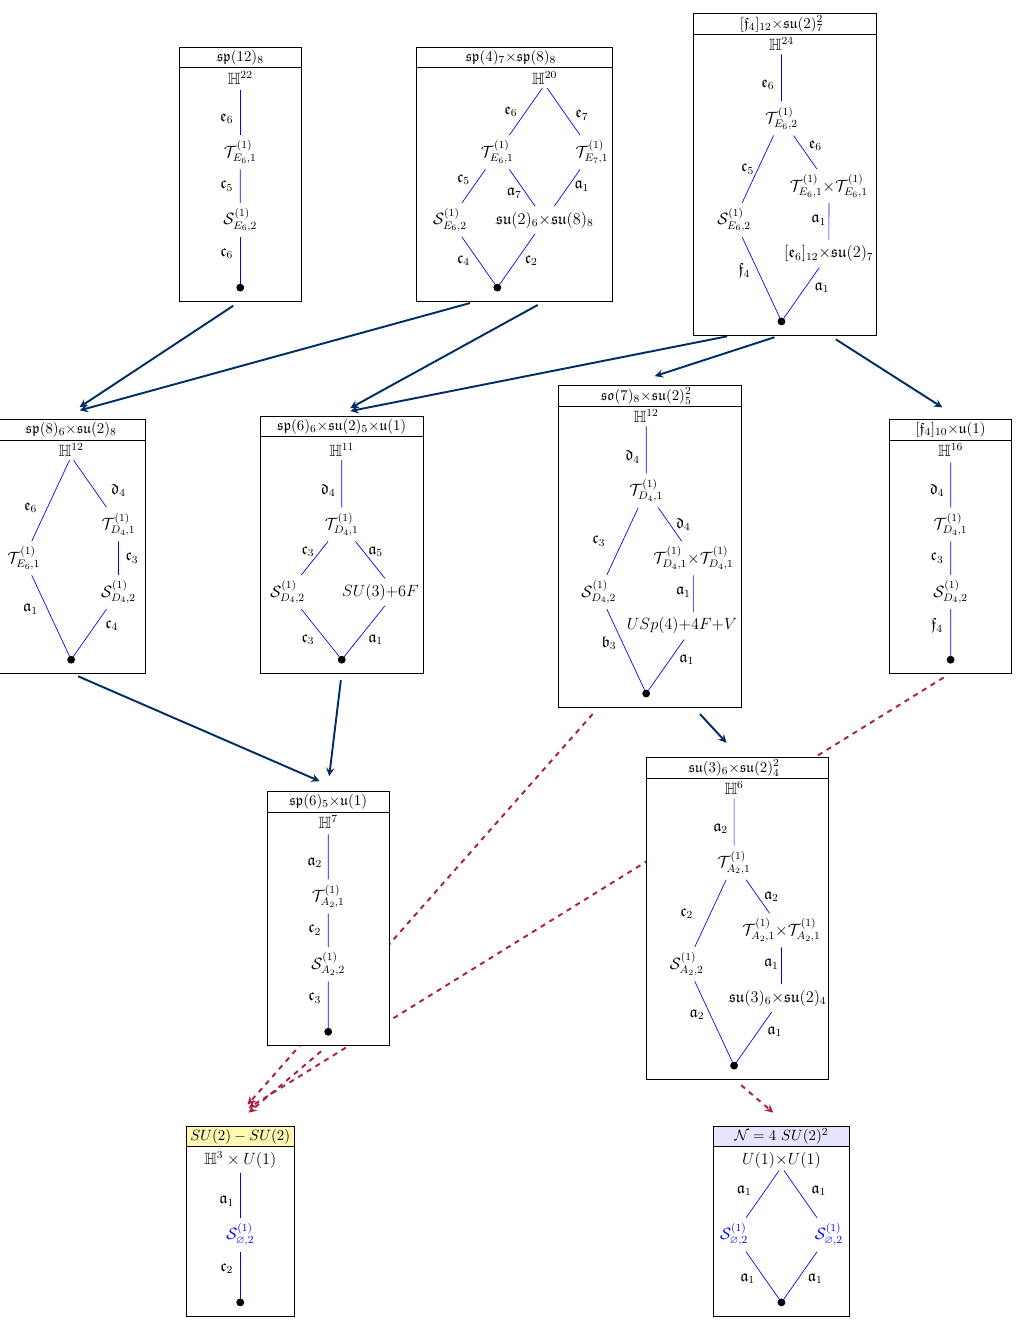
Figure 7 . Higgs branch analysis of the mass deformations among the entries of the sp (12) − sp (8) − f 4